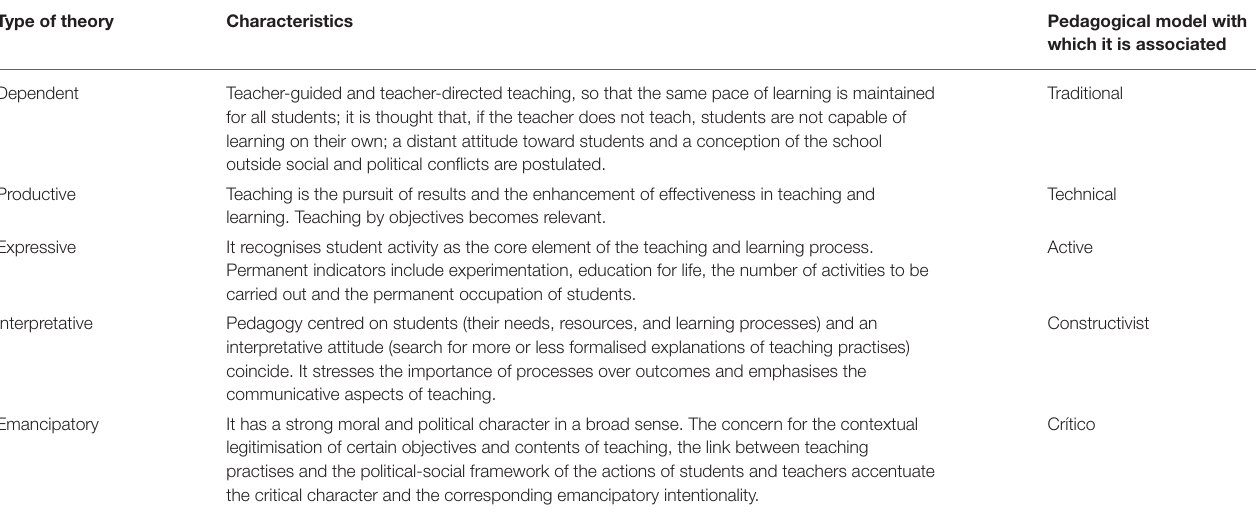
TABLE 1 | Generic classification model of implicit teacher theories (Marrero,